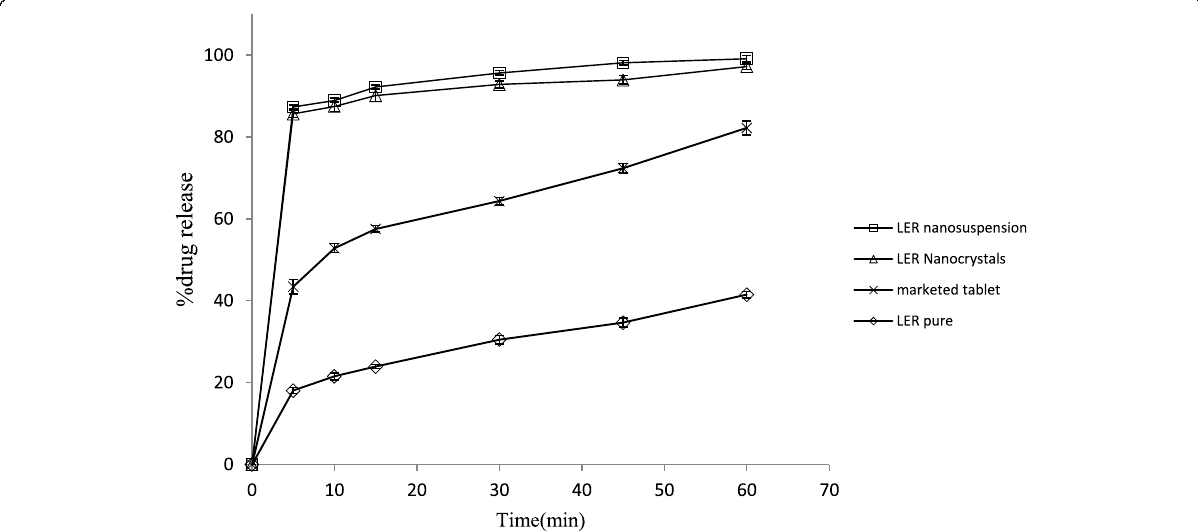
Fig. 11 Comparison of in vitro dissolution profile of LER pure, marketed tablet, LER nanosuspension, LER nanocrystals (average ± SD, n=3), n =